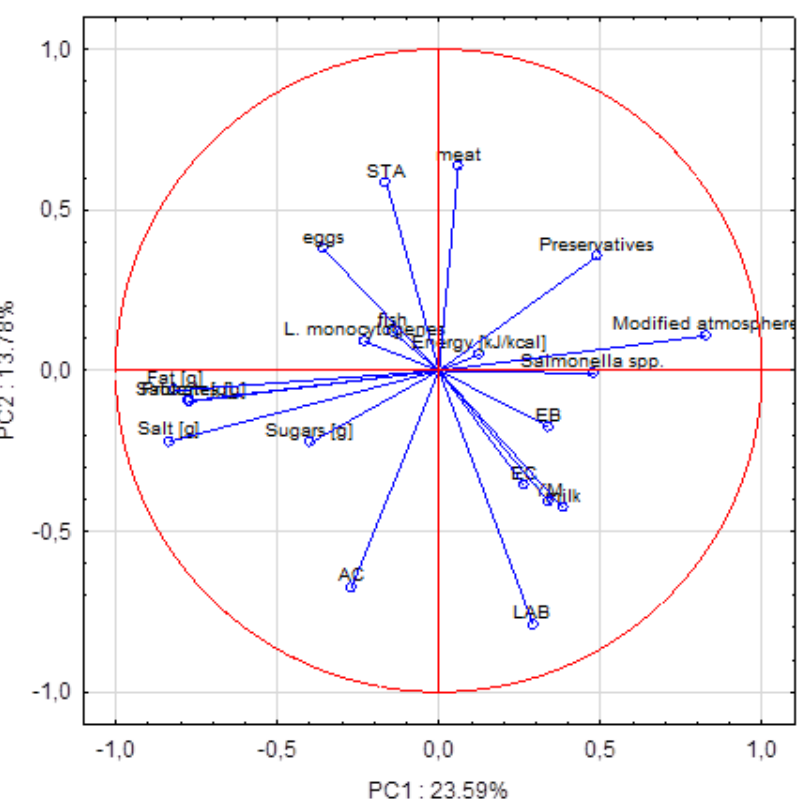
Figure 1. Dispersion of quality factors on a surface for the first two principal components (PC). Ex-